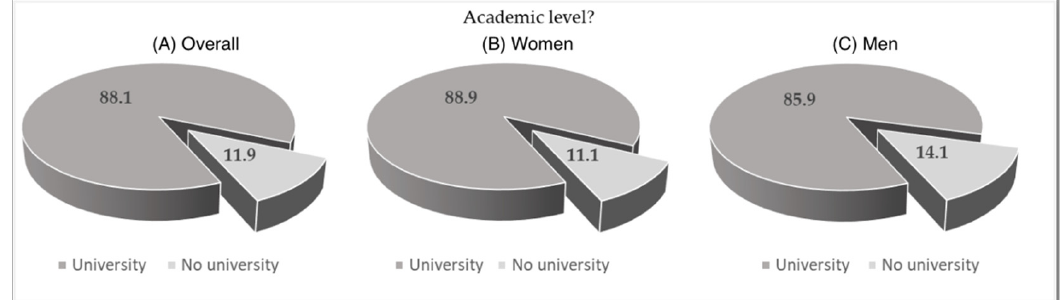
Figure 2. Academic level of WB-EMS users. ( A ) All samples; ( B ) women’s group; ( C ) men’s group. Regarding the motivation to practice (training goals), weight loss, health and wellness and increase in muscle mass are the main reasons for practice respectively. In the comparison between genders, there are significant differences in weight loss and rehabilitation ( p < 0.05 from pairwise z-test). Women look much more than men to lose weight and men look more than women to rehabilitation with WB-EMS (Figure 3).